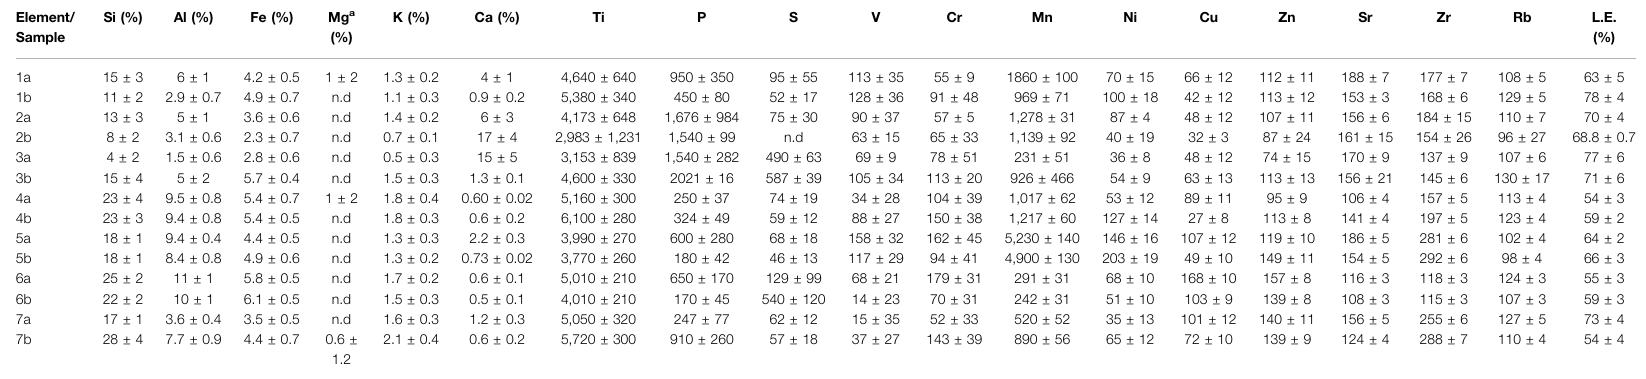
TABLE 2 | XRF composition of the samples. Results are presented in mg/kg unless other measurement units are provided and represent the average of fi ve determinations on randomly selected points ± SD. Element/ Si (%) Sample